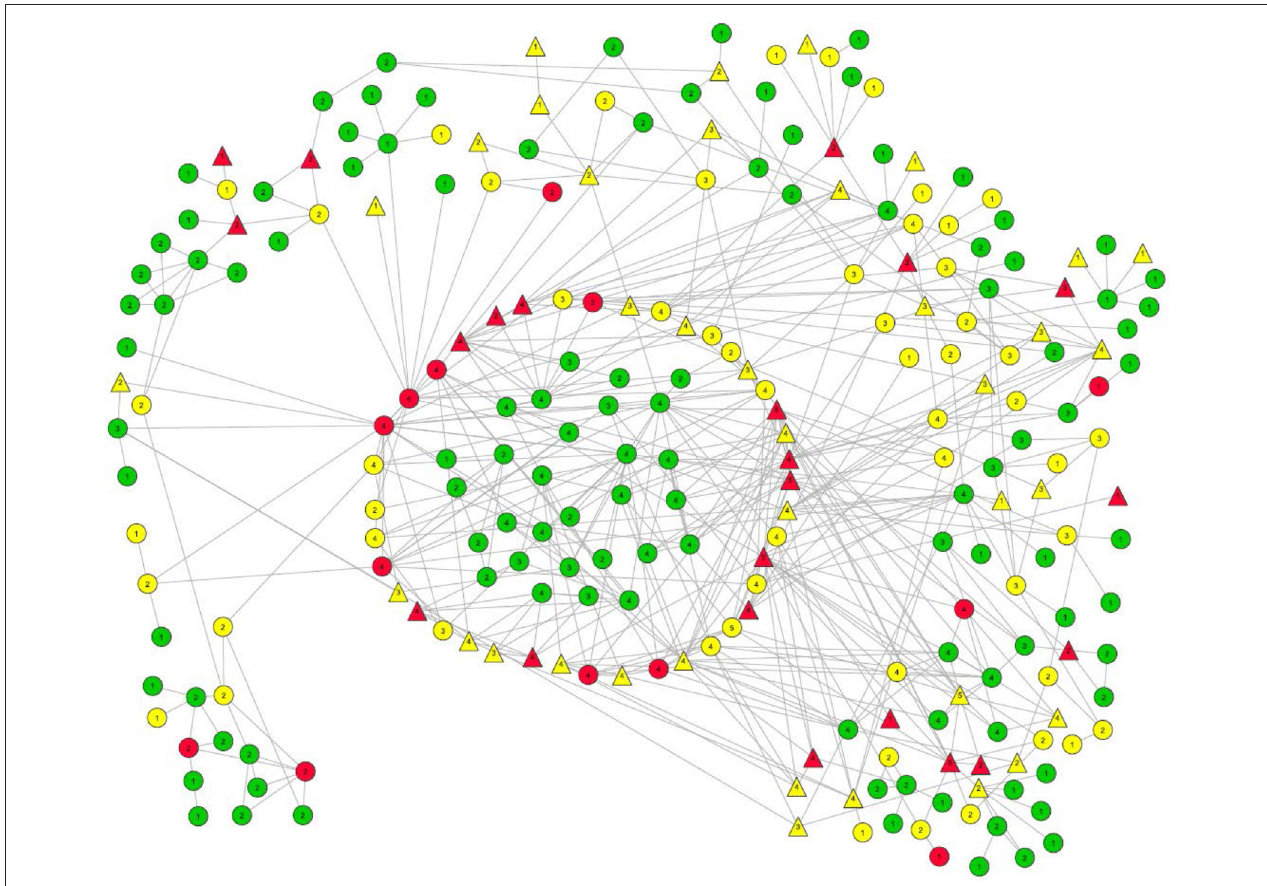
FIGURE 1 | Largest risk network component in the TRIP Athens data. Members of the pocket of non-infection that is the focus of this paper are located in the center. The ring directly around them is comprised of their direct alters. Other members of this large component ate located around the perimeter. HIV infection status: Long term positives are marked in yellow. Recently-infected are in red. Uninfected persons are in green. Numbers in the node symbols represent what K-level of the Seidman k-core the participant belongs to. Thus, if there is a “3” inside the node symbol, that participant is linked with at least two other members of the 3-core, and each member of that 3-core is linked to at least two other members of that 3-core. Viral load: Triangles represent those with viral load > 100,000 copies/mL. Everyone else is represented by a circle. Link types: Solid line = Injection Link Dash line = Sex Link Small-Dotted Line = Both Sex and Injection